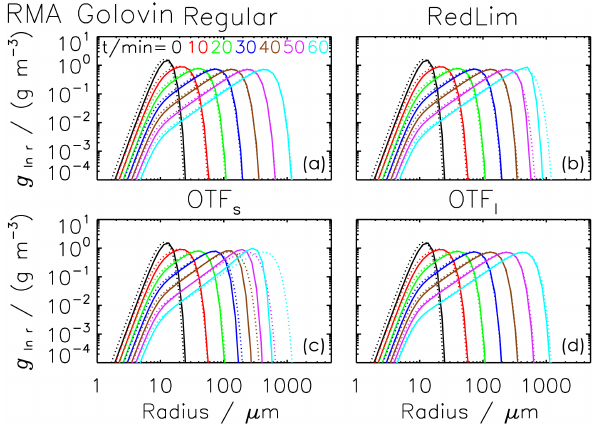
Figure 5. Mass density distributions obtained by RMA for the Golovin kernel from t 0 to 60min every 10min (from black to = cyan; see legend). The dotted curves show the reference solution; the solid curves show the RMA simulation results (ensemble aver- ages over 50 realisations). The parameter settings are singleSIP-init with weak threshold η 10 − 8 , κ 60 and (cid:49)t 1s. The follow- = = = Figure 6. SIP number and moments λ 0 and λ 2 as a function of time ing versions of RMA are depicted (clockwise from top left): regular obtained by RMA for the Golovin kernel. The black diamonds show version, version with the reduction limiter, version with update on the reference solution. The curves depict the RMA results (ensem- the fly (OTF l and OTF s ) (starting with combinations of the largest ble averages over 50 realisations). The default settings are proba- or smallest droplets, respectively). bilistic singleSIP-init with weak threshold η and (cid:49)t 1s. Left col- = umn: regular RMA version for various κ values (see legend in the middle) and threshold η 10 − 8 , 10 − 7 , 10 − 6 or 10 − 5 (solid, dot- = ted, dashed, dash-dotted; shown only for κ 40). Middle column: = the same as in the left column but for the RedLim version. Right col- umn: the version with update on the fly (solid lines show OTF s and dotted lines show OTF l ). The colours define κ as in the two other columns, but only the cases of κ 10 and 60 cases are =